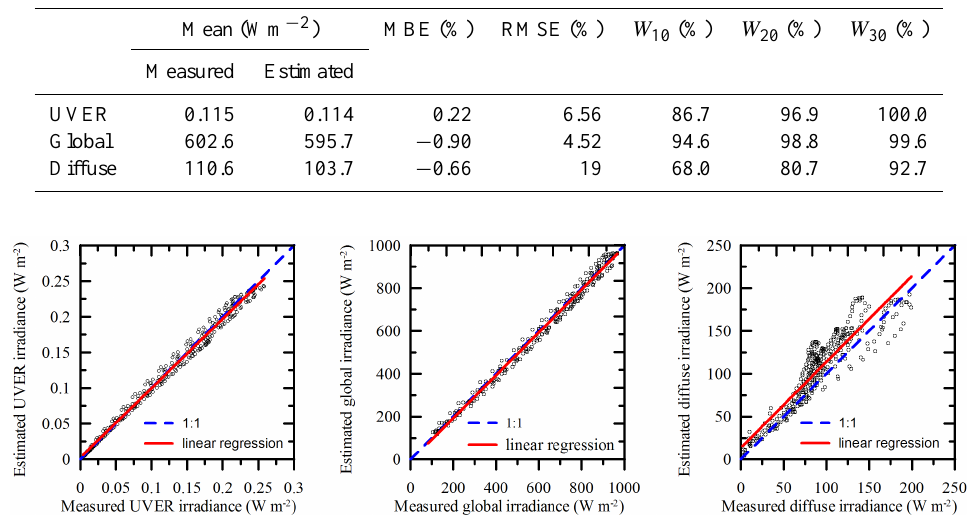
Table 3. Statistical estimators for the comparison of measured and estimated 10min UVER, global and diffuse solar irradiance at Marsaxlokk, Malta during the period August to October 2012.